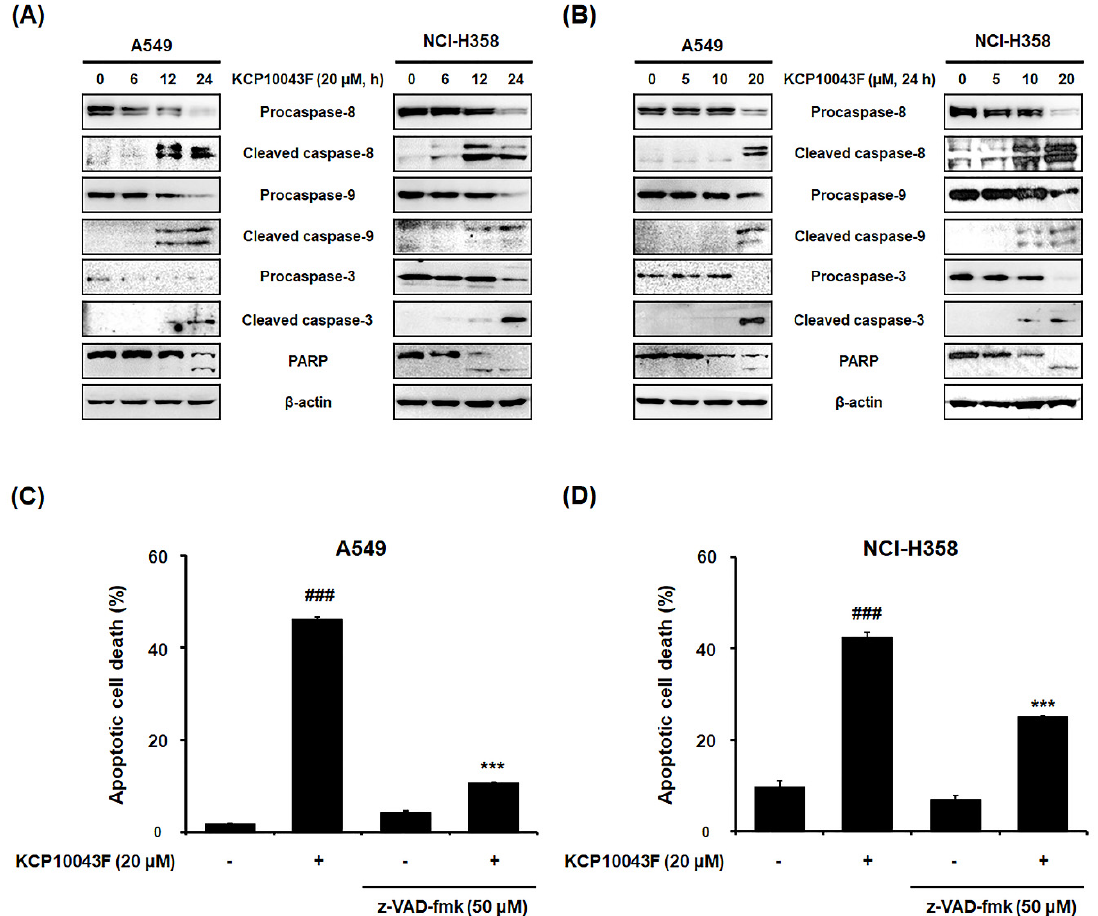
Figure 2. Activation of the caspase-dependent pathway by KCP10043F in A549 and NCI-H358 cells. ( A ) Cells were treated with 20 µ M KCP10043F for the indicated times (6, 12, or 24 h) and ( B ) treated with the indicated concentrations (5, 10, or 20 µ M) of KCP10043F for 24 h. The cells were harvested, and total cell lysates were prepared. The expression levels of procaspase-8, cleaved caspase-8, procaspase-9, cleaved caspase-9, procaspase-3, cleaved caspase-3, and poly (ADP-ribose) polymerase (PARP) were examined by Western blot analysis. β -actin was used as an internal control. ( C , D ) A549 and NCI-H358 cells with pretreated with a broad-caspase inhibitor (z-Val-Ala-Asp-fluoromethylketone (z-VAD-fmk)) for 1 h, followed by treatment with 20 µ M KCP10043F for 24 h. The cells were co-stained with annexin V-FITC and PI, and apoptosis was detected by flow cytometry. Data represent the mean ± SD of the results from three independent experiments. ### p < 0.001 vs. untreated control group, *** p < 0.001 vs. KCP10043F-treated group.